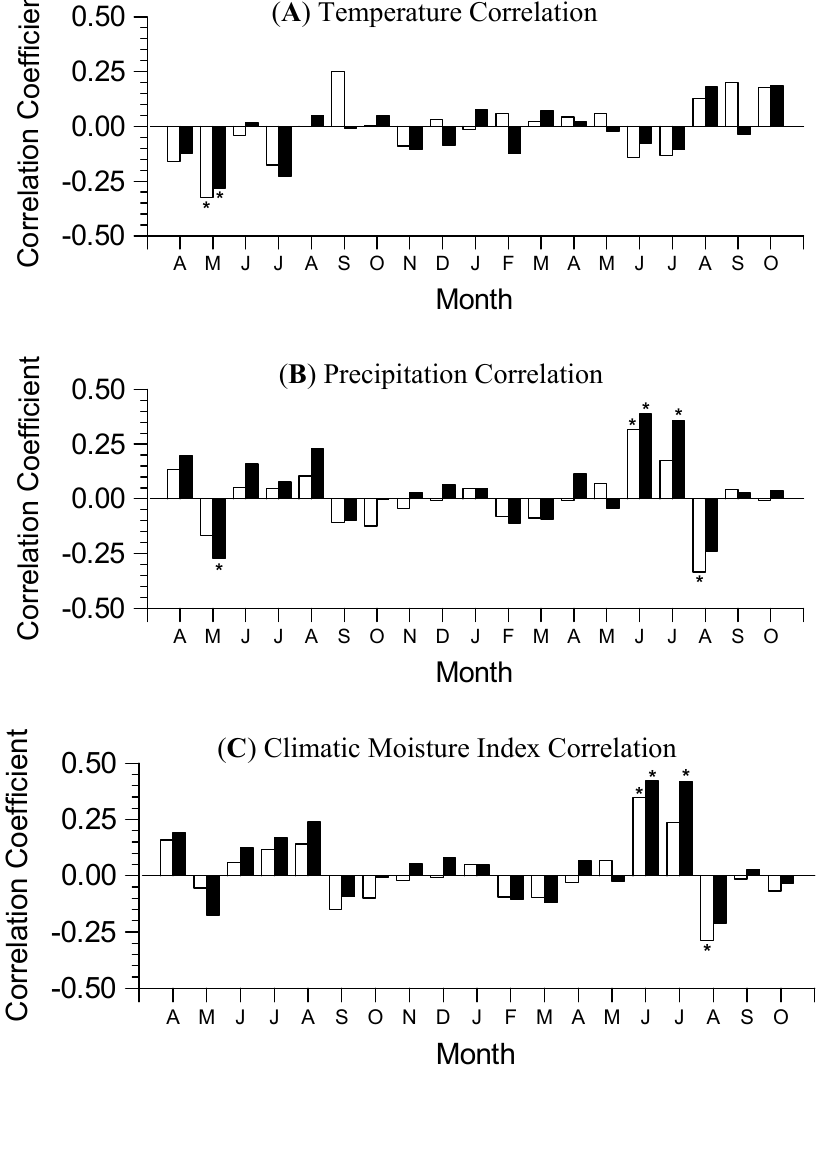
Figure 6. ( A ) Monthly temperature correlation, ( B ) monthly precipitation correlation and ( C ) monthly climatic moisture index correlation to radial growth of red pine in the Huron National Forest, Michigan, based on climate from 1965 to 2010. Analysis begins in April of the previous year until October of the current year. An asterisk denotes a significant correlation coefficient that is outside the 95% range of coefficients derived from 1000 bootstrapped iterations. LD (open bars) represents low density plots and HD (closed bars) represents high density